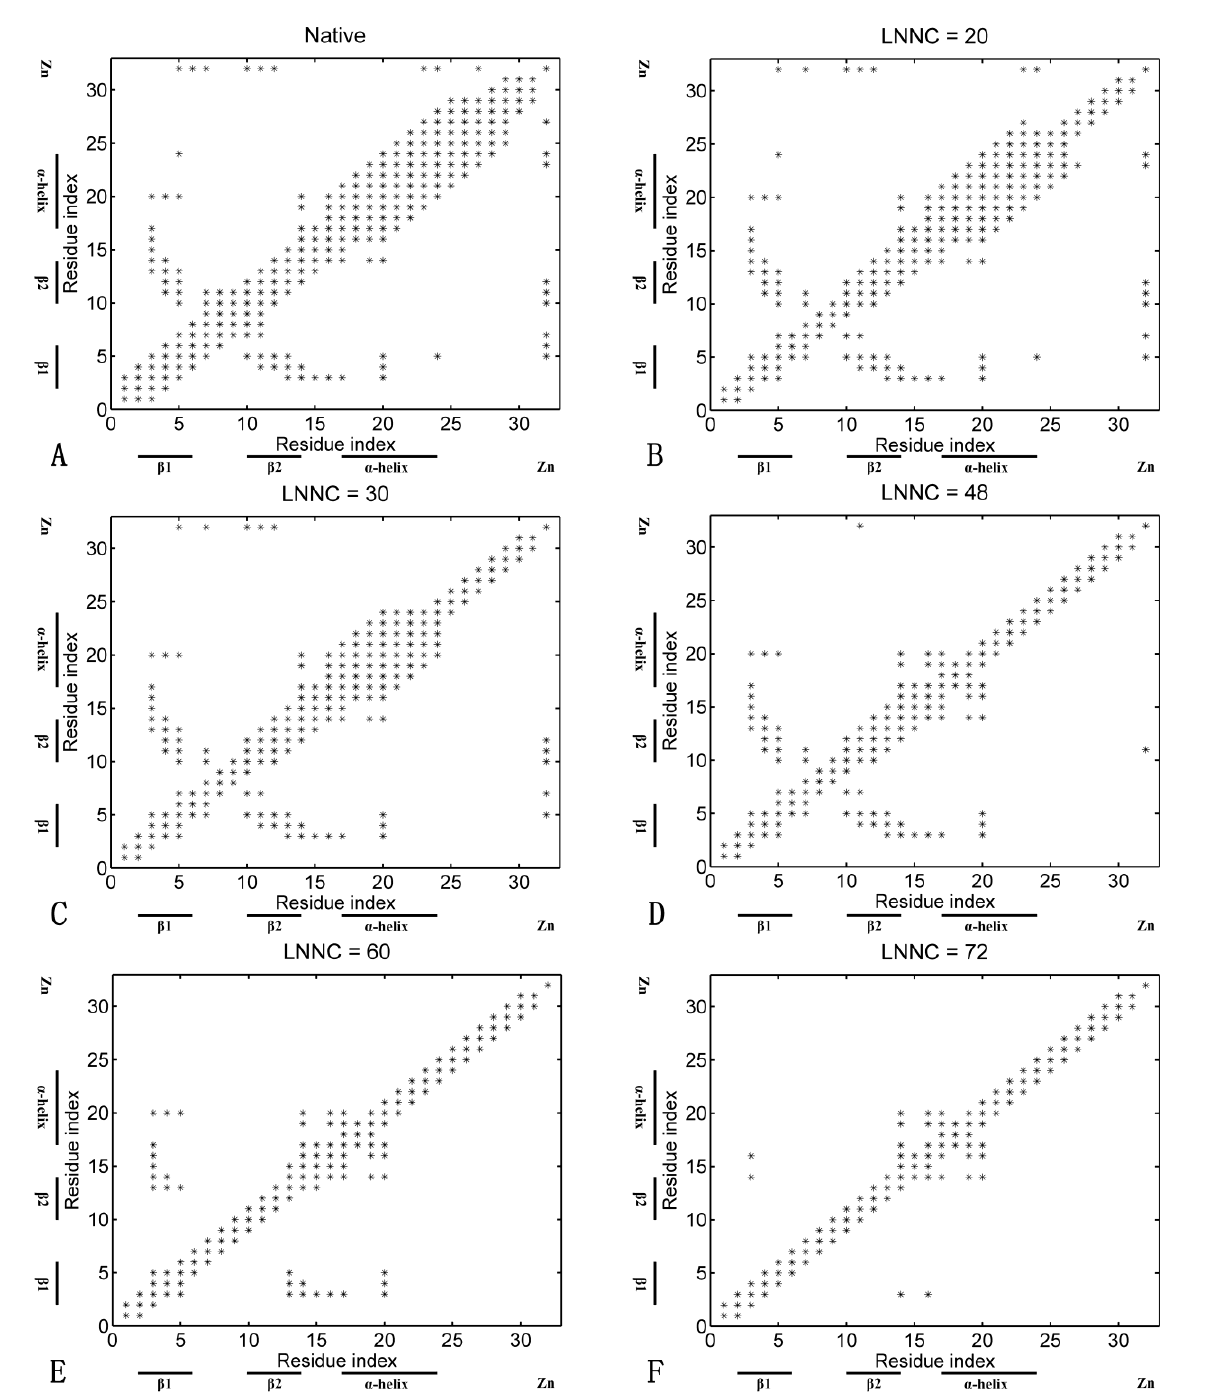
Figure 5. The contact maps of the native conformation ( A ), of the conformations with the LNNC to be 20 ( B ), 30 ( C ), 48 ( D ), 60 ( E ) and 72 ( F ) for Sp1f2, respectively. Each native contact is marked by the symbol * in the